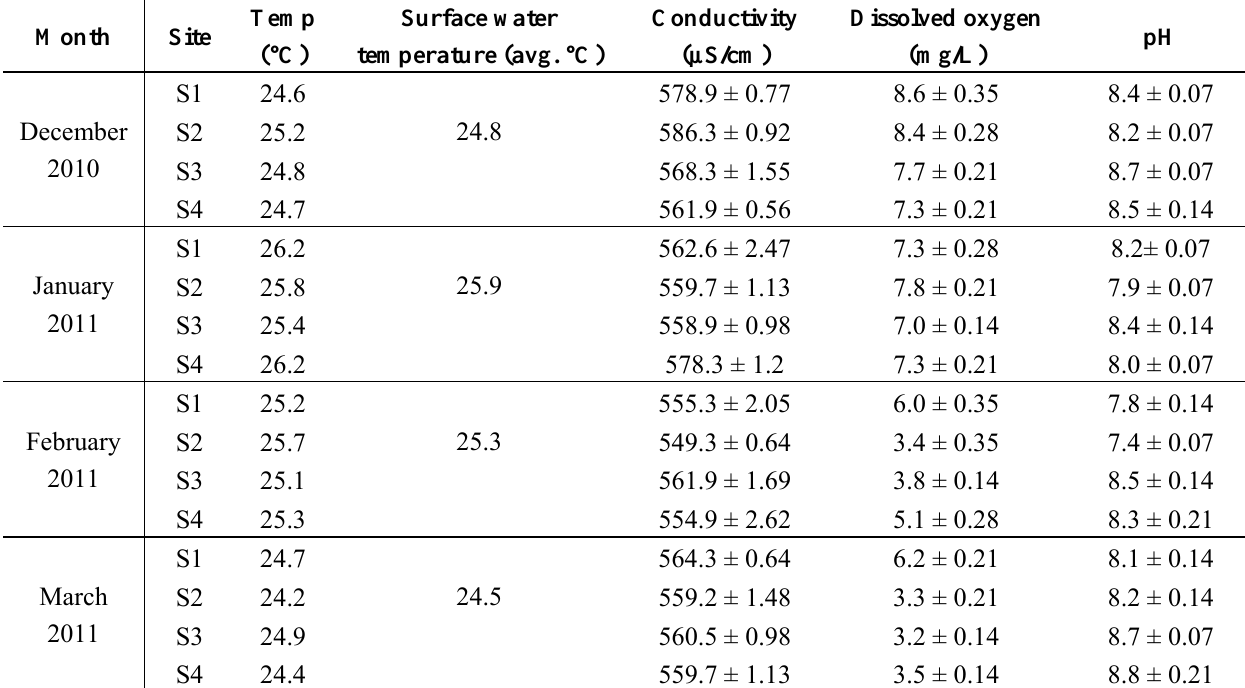
Table 1. Summary of on-site water parameters observed from each sampling site between December 2010 and March 2011.